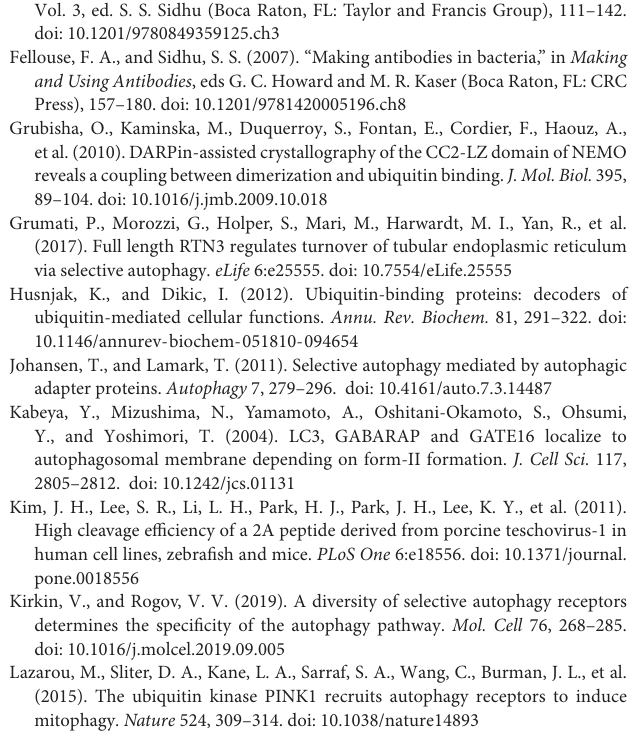
FIGURE S1 | Selection of specific binders. (A) Phage specificity ELISA for p62, OPTN and NDP52 binders obtained after the final round of phage selections. Binding of clones from p62 and OPTN selections was tested with BSA, GST and a panel of GST-fused proteins: ATG4A, ATG4B, ATG3, p62, NBR1, OPTN, BNIP3, and NIX. Binding of clones from NDP52 selections was tested with BSA, GST and GST-fusions of LIR-containing peptides of human NDP52 and two unrelated proteins of fungal origin (Pa6948 and PaWBD1), as well as their (cid:49) LIR versions. In all cases, anti-Flag antibody was used as positive control. (B) Phage IC 50 ELISA of p62-specific clones. Selected clones were pre-incubated in solution with